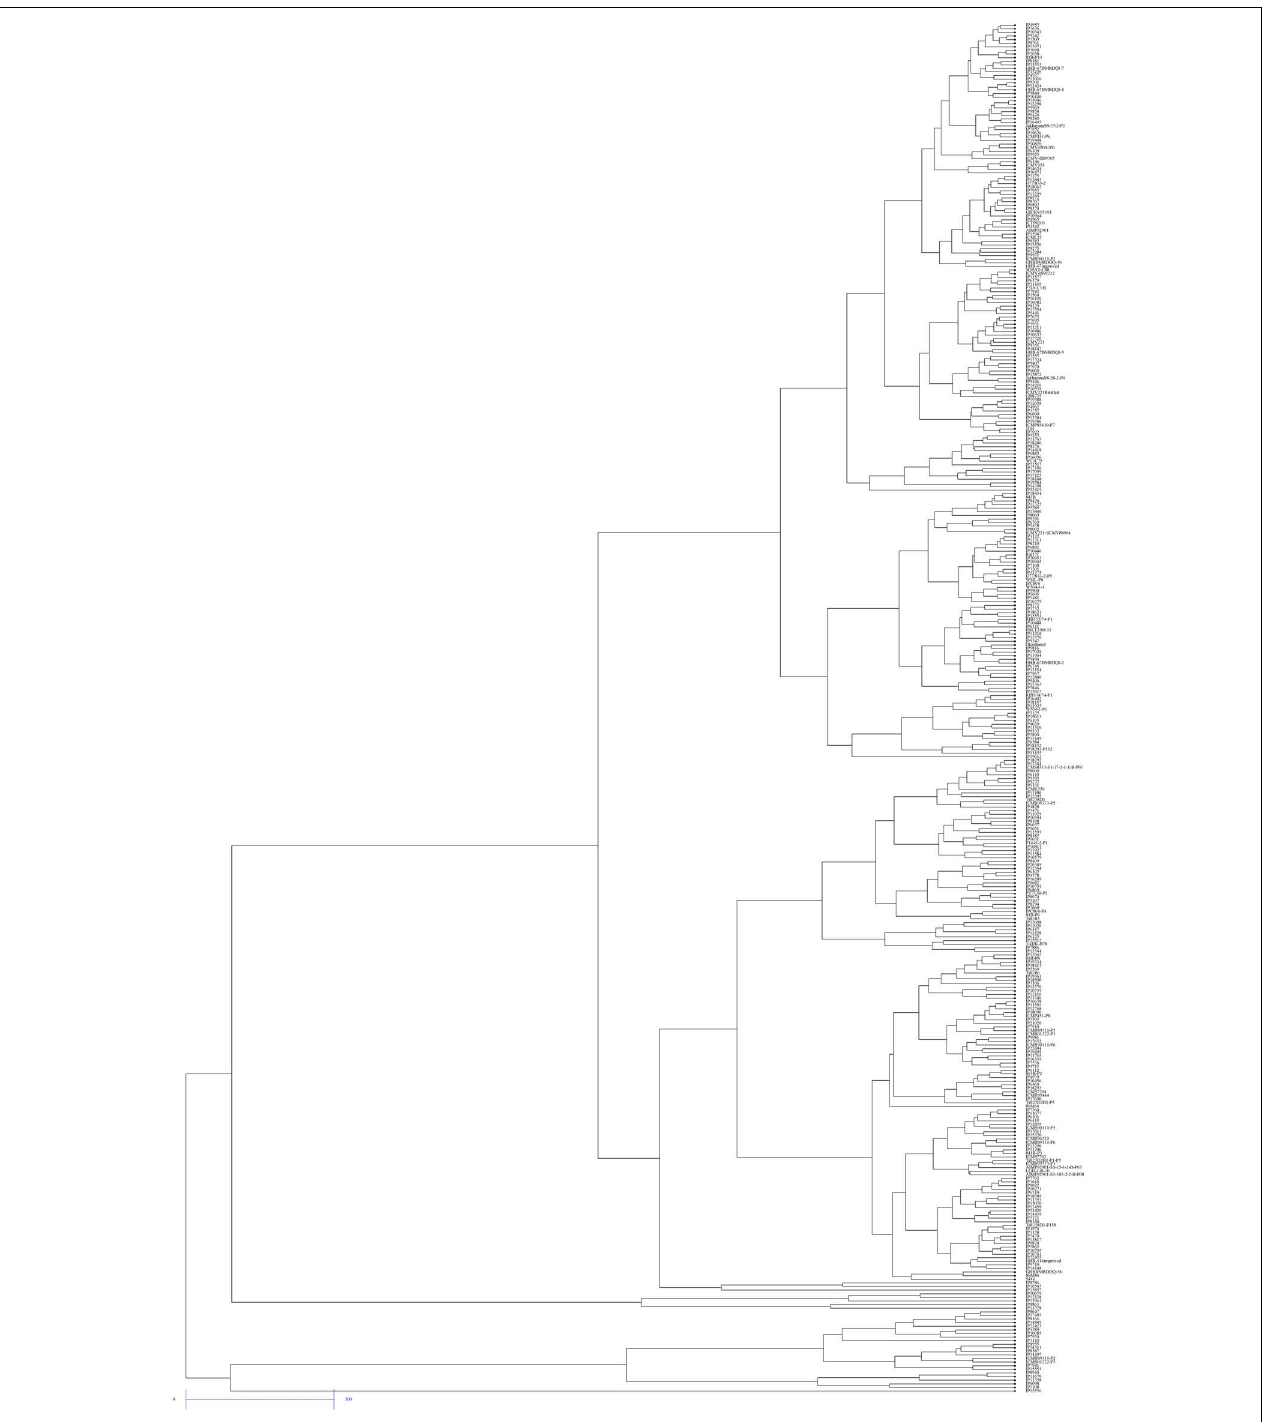
FIGURE 8 | Dendrogram of 380 pearl millet genotypes for five traits under recommended conditions of nitrogen (N 100 ) by the UPGMA method.